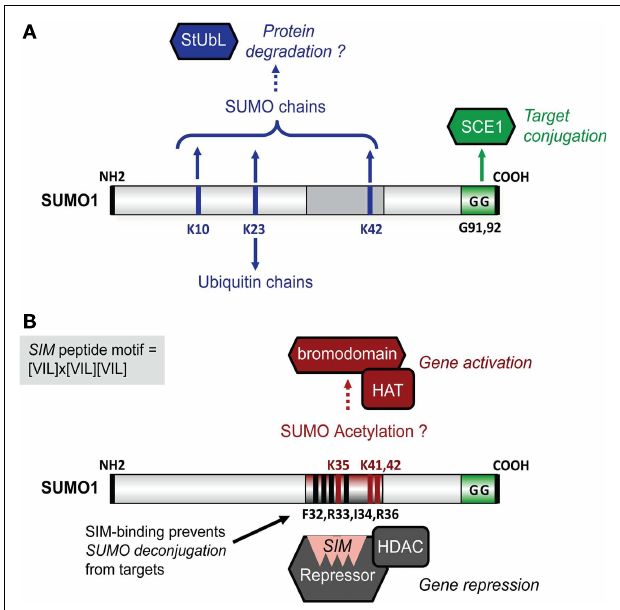
FIGURE 1 | Schematic structure ofArabidops SUMO1 and its potential interplay with other post-translational modifications. (A) SUMO is conjugated to targets via SCE1 that forms an isopeptide with diGly residues (GG) of SUMO and Lys residues in target proteins. SUMO1 and SUMO2 ( not shown ) contain also internal acceptor sites for SUMO chain editing (Lys10, Lys23, and Lys42; top ) and mixed ubiquitin-SUMO chains (Lys23; bottom ). SUMO chains are recognized by StUbLs that conjugate ubiquitin on internal lysines in SUMO chains.This leads to 26S proteasome-mediated protein degradation of SUMO conjugates. (B) A SUMO-acetylation switch controls gene regulation by SUMO-modified targets. For example, SIM-dependent recruitment of co-repressor complexes is linked with (HDAC-mediated) gene repression ( bottom ).These SUMO-SIM interactions are disrupted by SUMO acetylation ( top ), which likely involves HAT activity. On the other hand, SUMO acetylation (on possibly Lys35, Lys41, and/or Lys42) allows SUMO instead to interact with bromodomains; a domain found in transcriptional co-activators. In addition, SUMO-SIM interactions appear to prevent SUMO deconjugation by SUMO